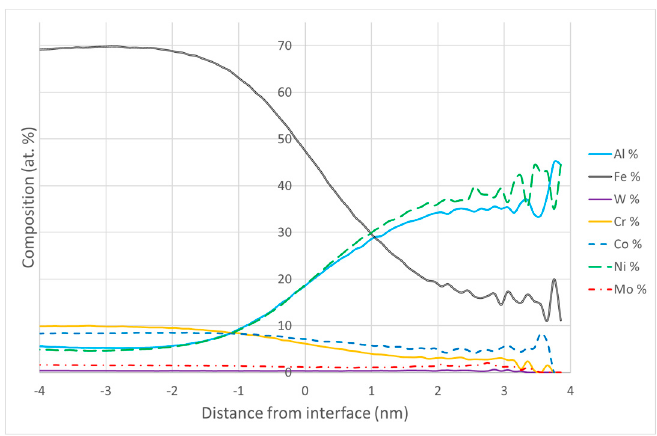
Figure A1. A composition proxigram of NiAl precipitates in the alloy after austenitisation at 960 °C and ageing at 540 °C for 5 h. The isosurface used to determine the proxigram was 17 atm. % Ni. Table A1. Scattering length density values of NiAl, found from composition of NiAl after ageing at 540 °C for 5 and 7.5 h. See Equation (A1) for details for determination of neutron scattering length densities.